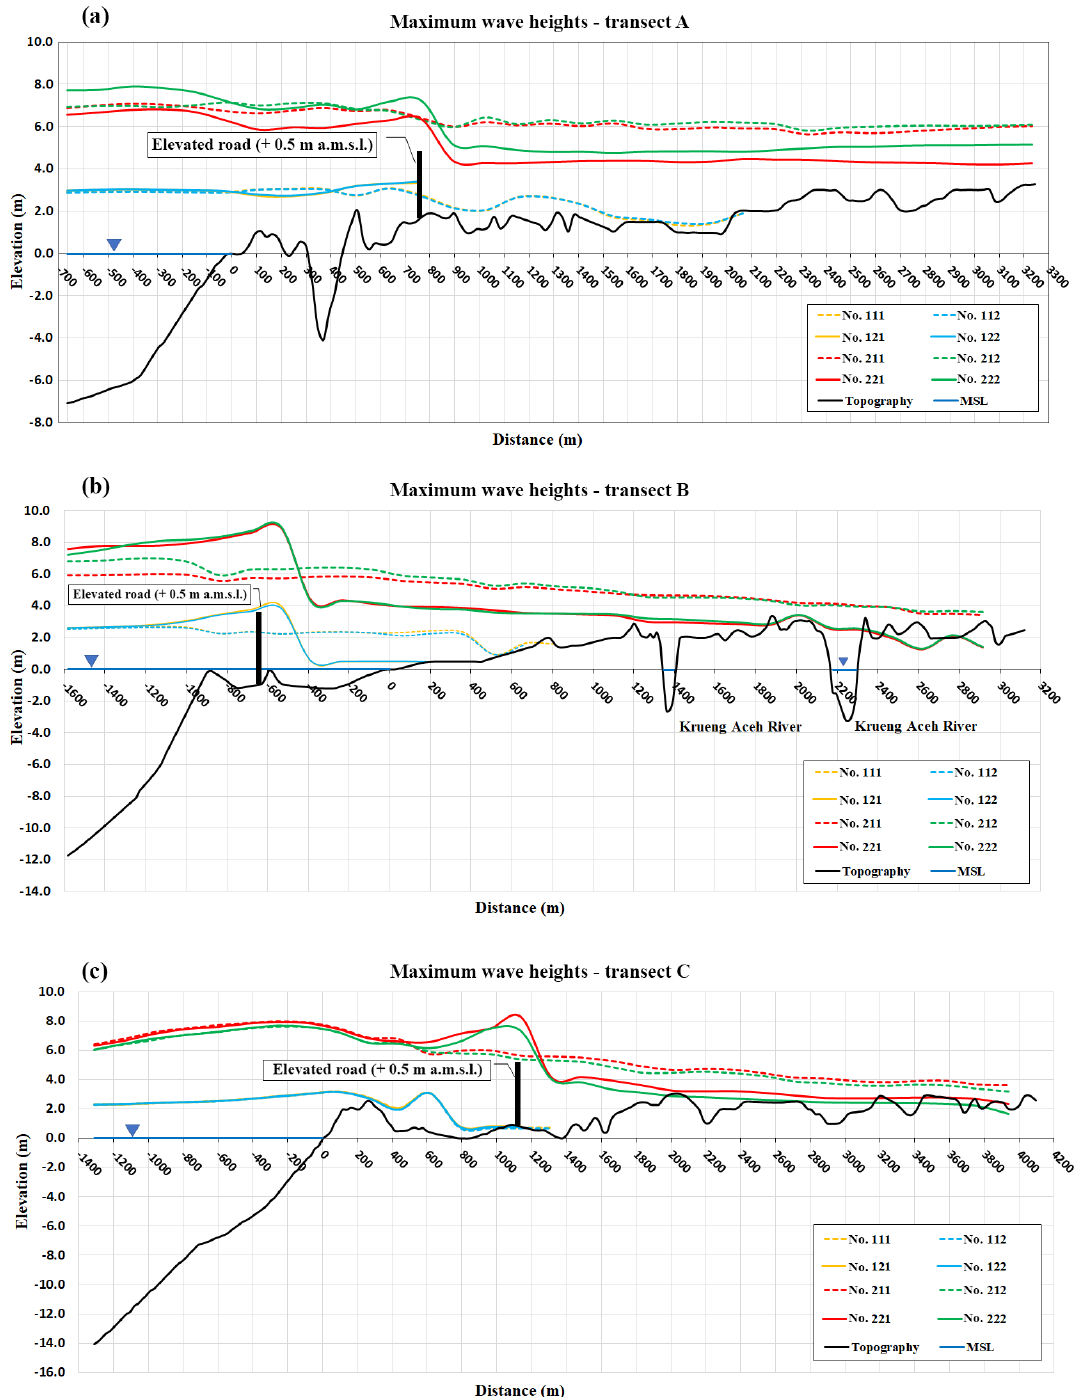
Figure 12. The comparison of tsunami wave heights at transects A, B, and C based on scenarios with and without BORR.